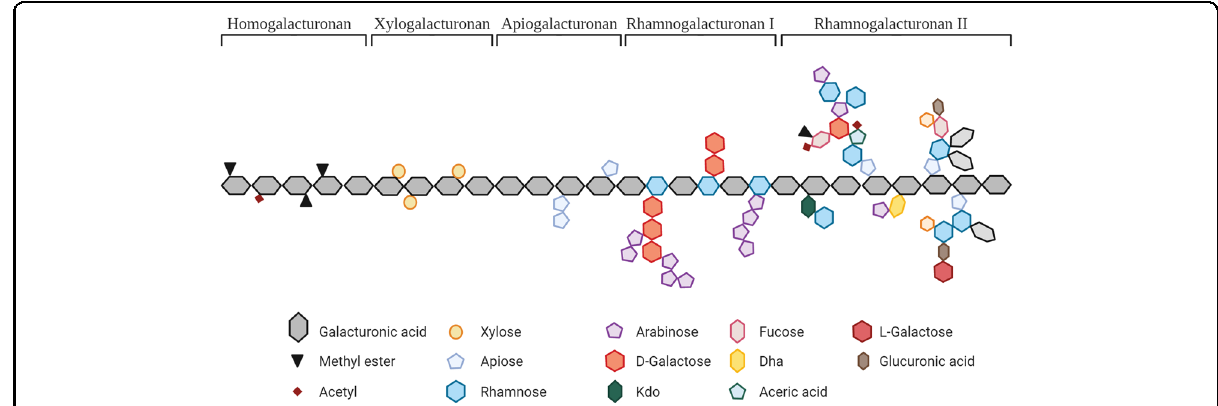
Fig. 2 Structural characteristics of pectin molecules. A pectin molecule can contain different structural characteristics, including homogalacturonan, xylogalacturonan, apiogalacturonan, rhamnogalacturonan I, and rhamnogalacturonan